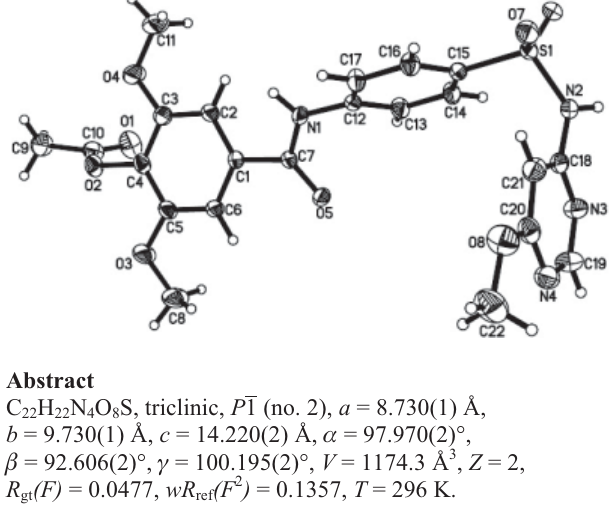
Table 1. Data collection and